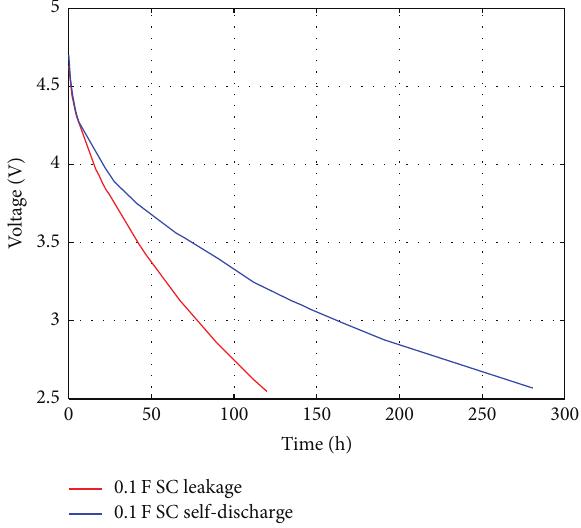
Figure 12: Leakage and self-discharge of a 0.1F SC.